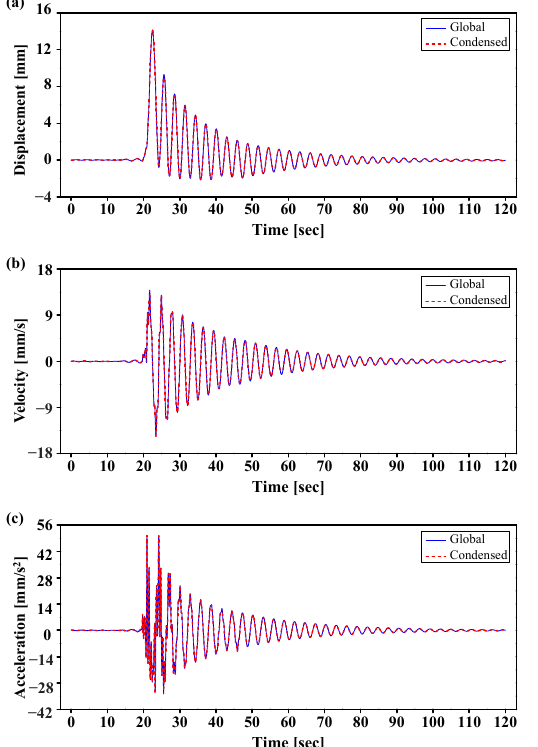
Figure 11. Transient analysis results for #1 node: ( a ) Displacement, ( b ) Velocity, and ( c ) Acceleration.